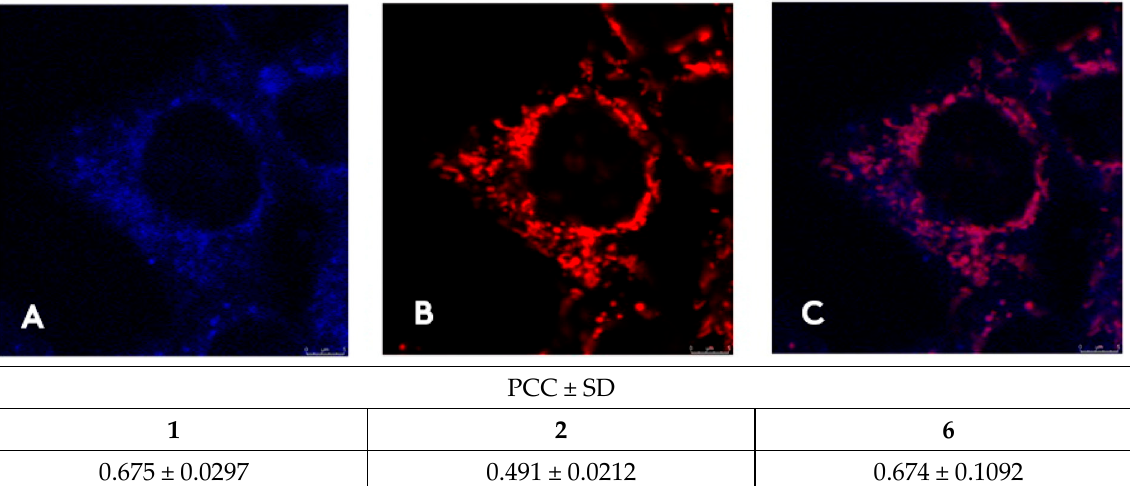
Figure 8. Intracellular distribution of dye 6 compared to MitoTracker. Confocal microscopy of live HeLa cells taken on Leica SP8 X confocal microscope, stained with 1 μ M of compounds 6 ; ( A ) channel showing emission of 6 ( λ exc = 405 nm, λ em = 470–670 nm); ( B ) MitoTracker channel ( λ exc = 644 nm, λ em = 665–700 nm); ( C ) overlay of the two channels. Colocalization correlation, PCC values corrected for noise by the RBNCC method for cyanines 1 , 2 and 6 .